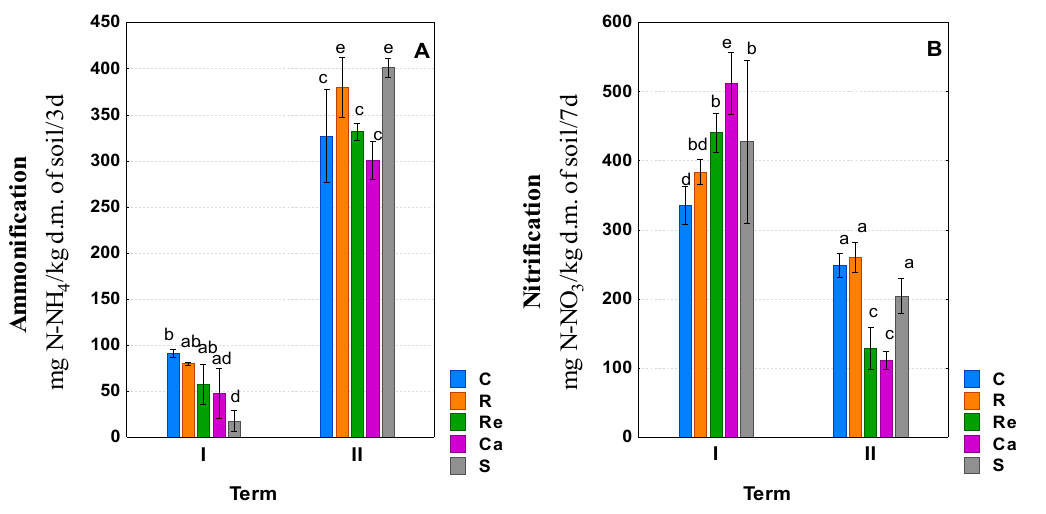
Figure 2. Biochemical activity in the soil. Legend: ■ C-control (without pesticides), ■ R-herbicide Roundup, ■ Re-herbicide Reglone, ■ Ca-fungicide Caramba, ■ S-adjuvant Spodnam. A—Ammonification process, B—Nitrification process.